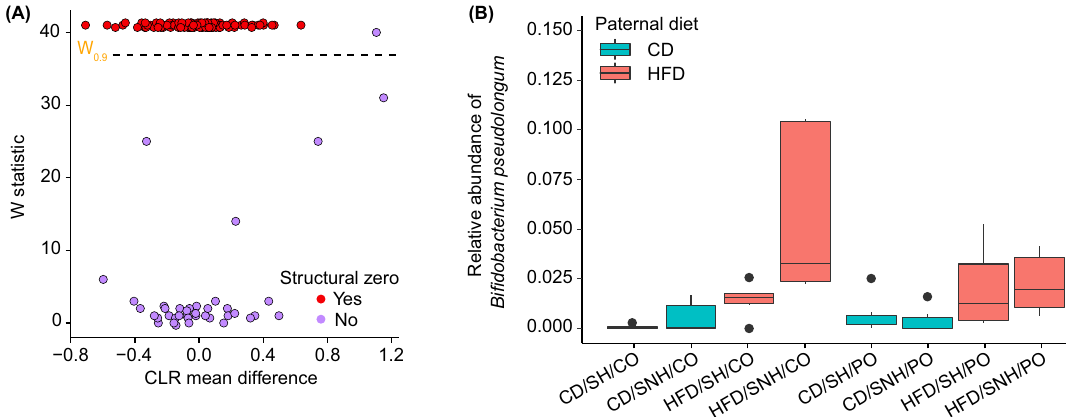
Figure 7. Bifidobacterium pseudolongum significantly contributes to differential microbiome compositions observed among F 1 offspring of control diet (CD) and high-fat diet (HFD) F 0 sires. ( A ) Analysis of composition of microbiomes (ANCOM-II) volcano plot showing the mean center-log ratio (CLR) differences in abundance and W-statistics for taxa that are differentially abundant in a test of F 0 paternal dietary condition × maternal housing condition. Significant taxa that drive differences in the model lie above the coefficient of concordance threshold of 0.9 (horizontal black dashed-line; purple circle). Note that some significant taxa are also defined as structural zeros (red circles; Mandal et al. 80 ). Non-significant taxa lie under the threshold. ( B ) Relative abundance plot of Bifidobacterium pseudolongum , the only significant taxon detected in the ANCOM-II analysis. The horizontal black lines indicate the medians; bottoms and tops of boxes indicate the first and third quartiles, respectively; whiskers indicate the 1.5 interquartile range beyond the upper and lower quartiles. Values outside the whiskers are indicated by black circles. ANCOM-II analysis of composition of microbiomes, CD control diet, CLR center-log ratio, CO control odor, HFD high-fat diet, PO predator odor, SH standard housing, SNH semi-naturalistic